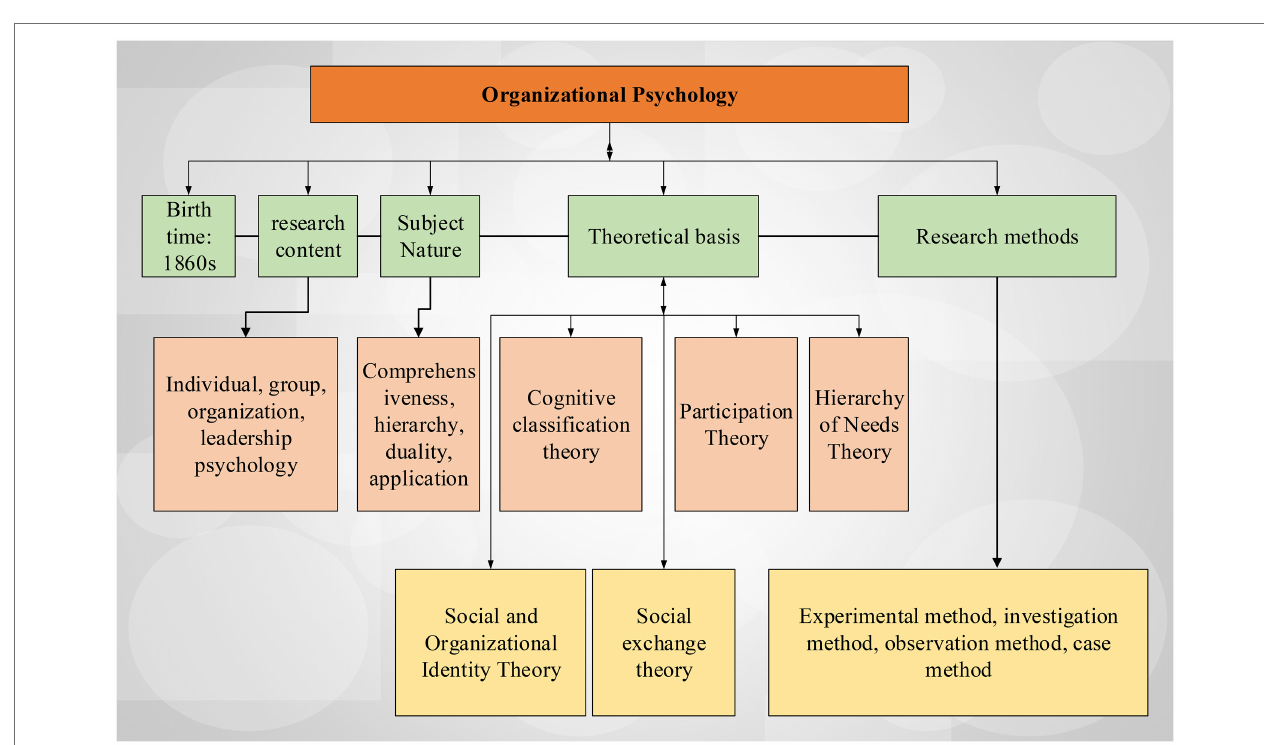
FIGURE 2 | An overview of organizational psychology